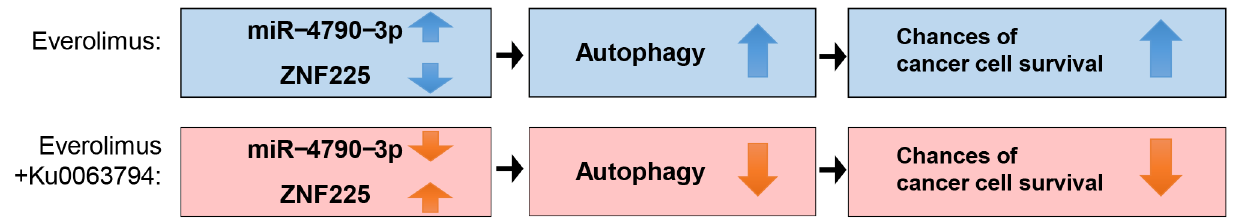
Figure 6. Possible mechanism of action comparing everolimus monotherapy and everolimus and Ku0063794 combination therapy.